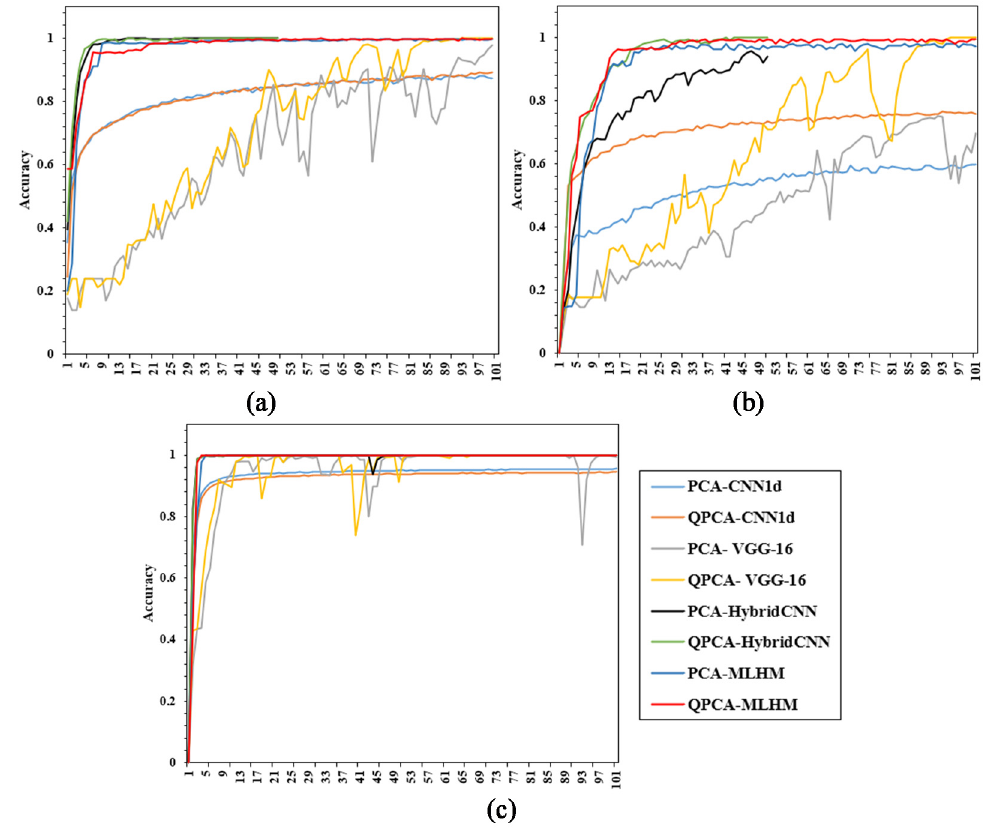
Figure 11. The training accuracy in each model for the three used datasets: ( a ) IPs dataset, ( b ) the Pavia University dataset, and ( c ) the KS_Center dataset.